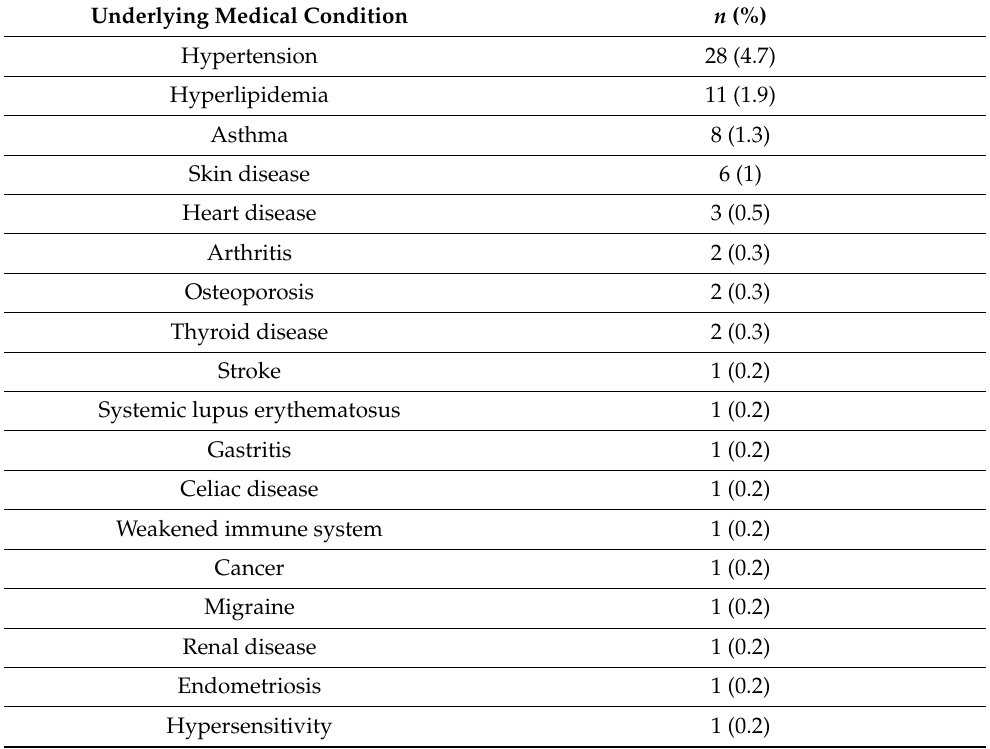
Table 2. The underlying medical conditions among the respondents ( n =